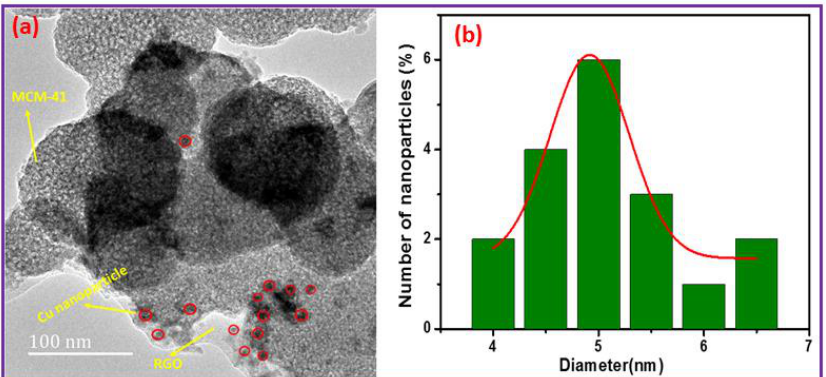
Figure 4. ( a ) An HRTEM image of 5 Cu(0)-AAPTMS@RGO-MCM-41 and ( b ) a histogram of the particle size distribution for the Cu nanoparticles.